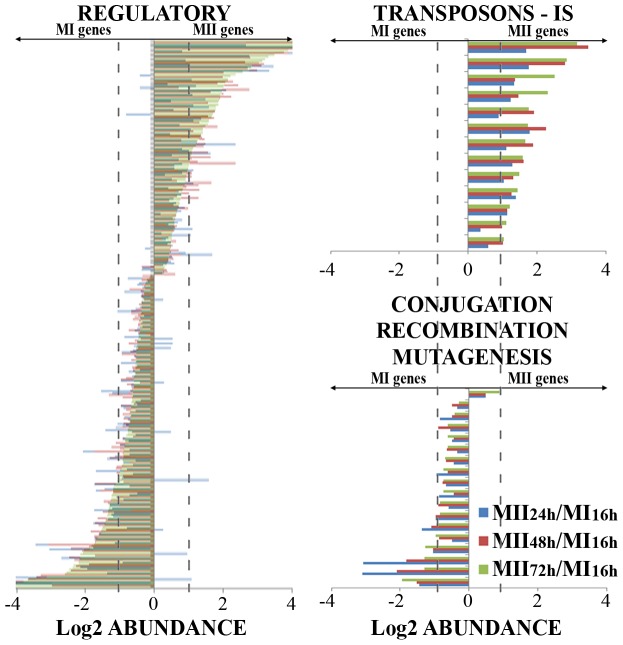
Gene abundance values (log2 MII/MI) of the genes grouped in functional categories (continuation).Regulatory proteins (transcriptional regulators, kinases, other regulatory proteins); transposons - insertion sequences; conjugation, recombination, mutagenesis. Dashed lines indicate the limit for considering abundance variations significant (log2 abundance ±1).